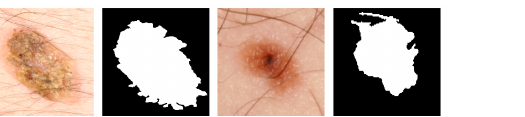
Figure 6. Examples of questionable segmentation labels of the Dermofit Database.